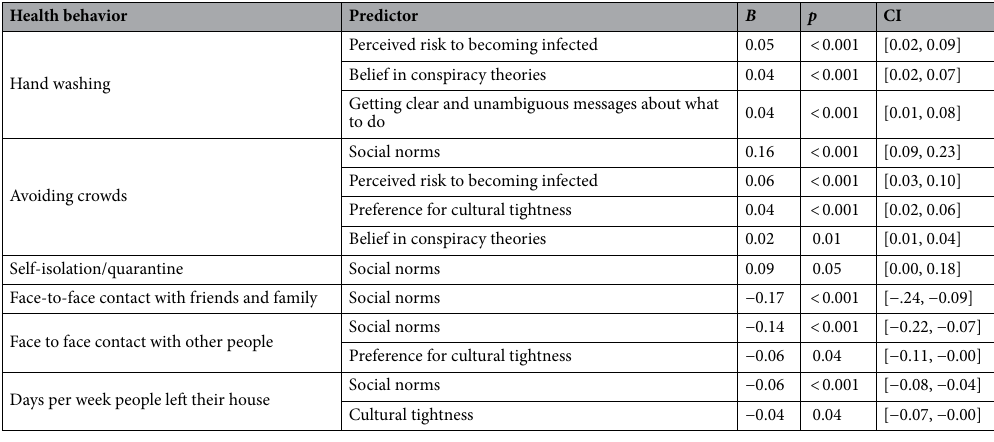
Table 1. Predictors of health